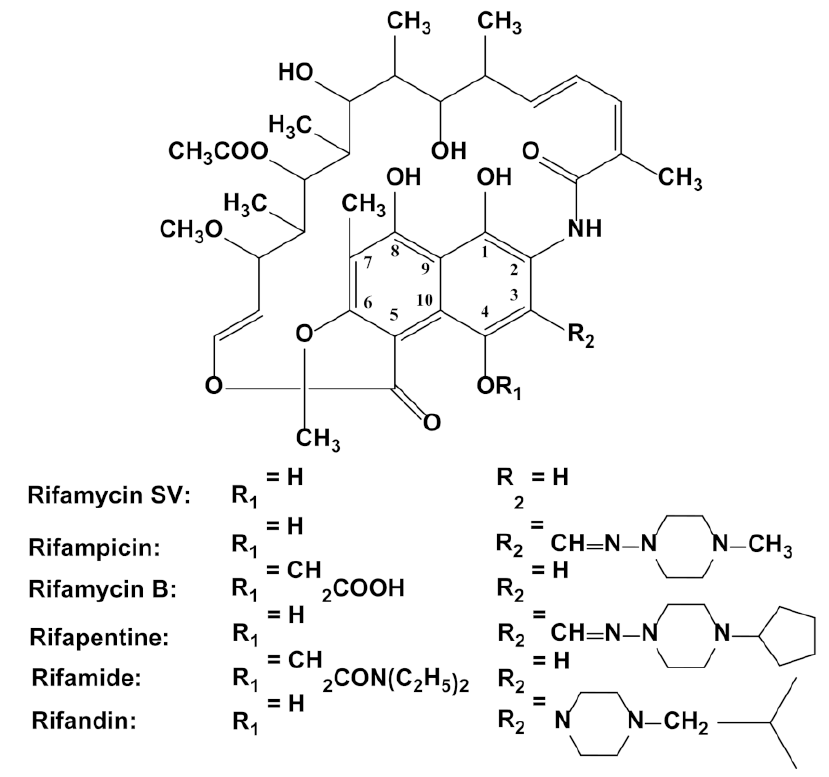
Figure 1. Chemical structure of the most common